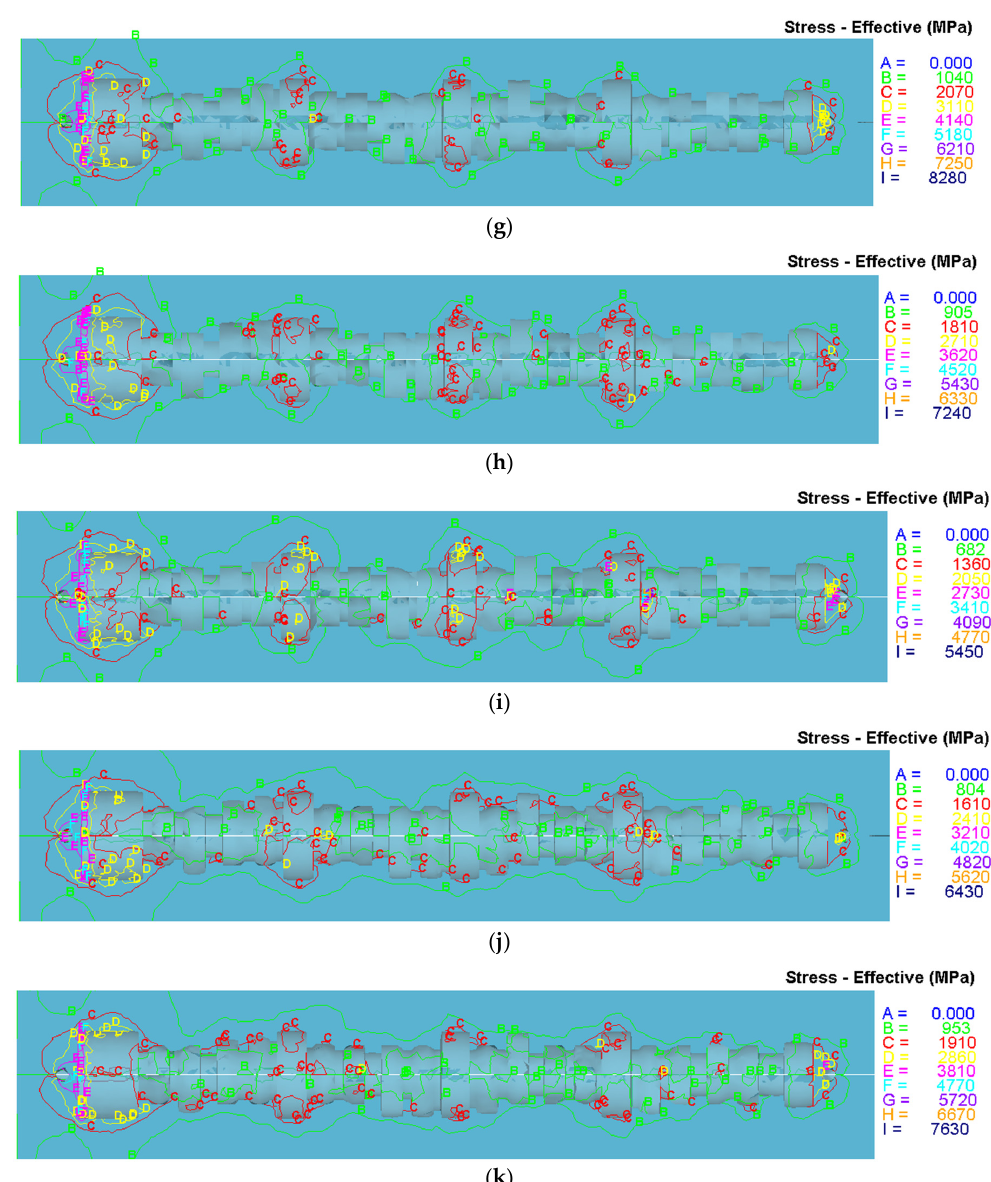
Figure 9. Effective stresses in the punch and die. ( a ) Case I; ( b ) Case II; ( c ) Case II; ( d ) Case IV; ( e ) Case V; ( f ) Case VI; ( g ) Case VII; ( h ) Case VII; ( i ) Case IX; ( j ) Case X; ( k ) Case VI (filleted Dies).